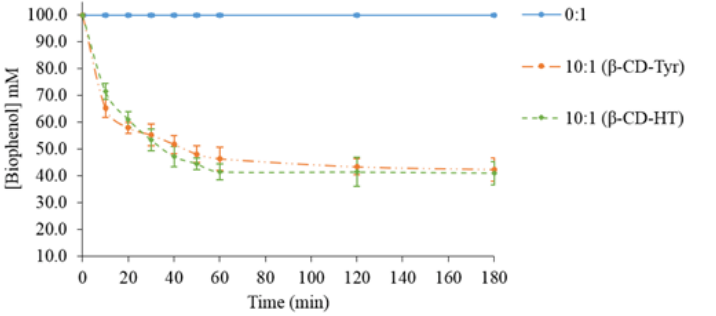
Figure 2. Time-dependence of the biophenol concentration in a concentrated aqueous solution according to the β -CD/phenol molar ratio of 10:1.